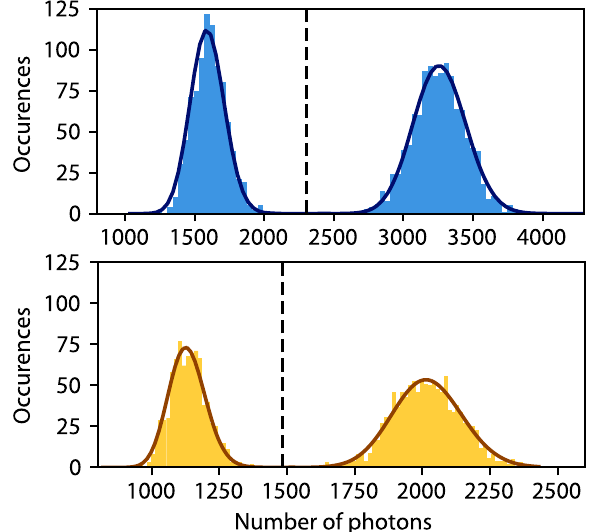
7. Example atomic fluorescence histograms. Sample fluorescence counts for a single Rb atom (top) and a single Cs atom (bottom) collected during a 40-ms imaging time. Thresh- olds (dashed lines) are placed between the atom and background signals by fitting the fluorescence counts to a bimodal Poisson distribution and extracting the minimum between the modes.